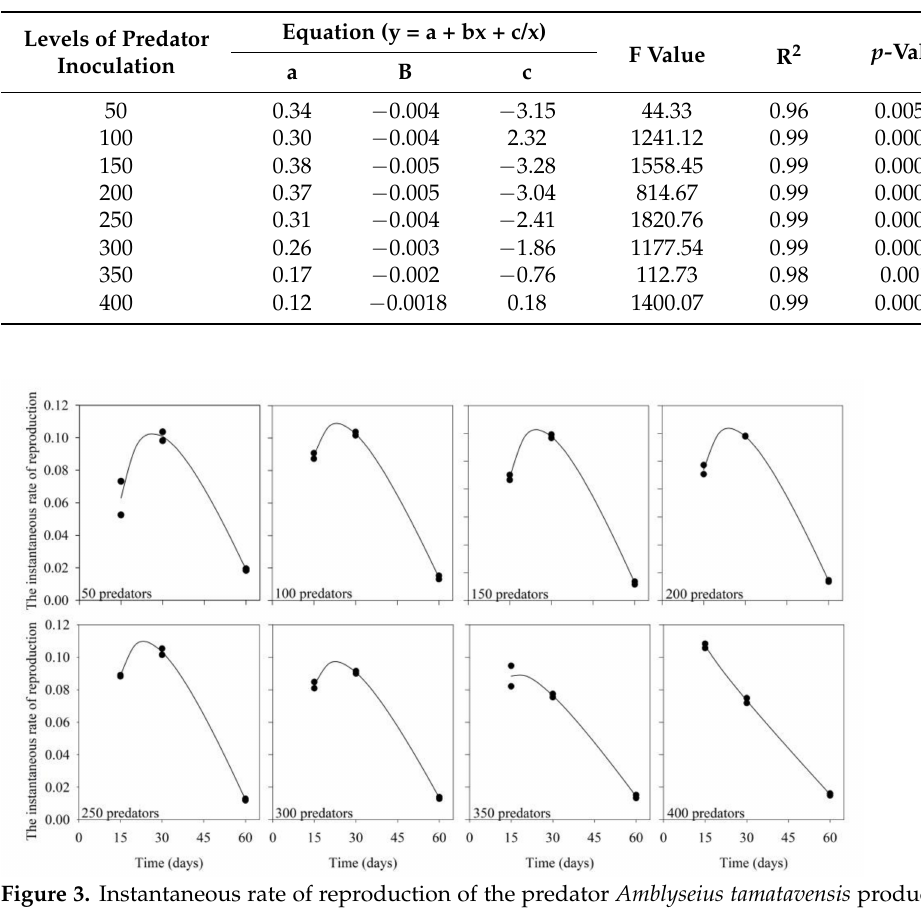
Figure 2. Density of Amblyseius tamatavensis in each 500 mL container at different production periods on Thyreophagus cracentiseta , for different levels of predator inoculation (25 ± 1 ◦ C, 70 ± 10% RH, in the darkness). Table 2. Regressions between instantaneous rate of increase of the predator Amblyseius tamatavensis and its maintainment times on Thyreophagus cracentiseta , by considering different levels of predator inoculation ( n = 6 containers per predator inoculation level).